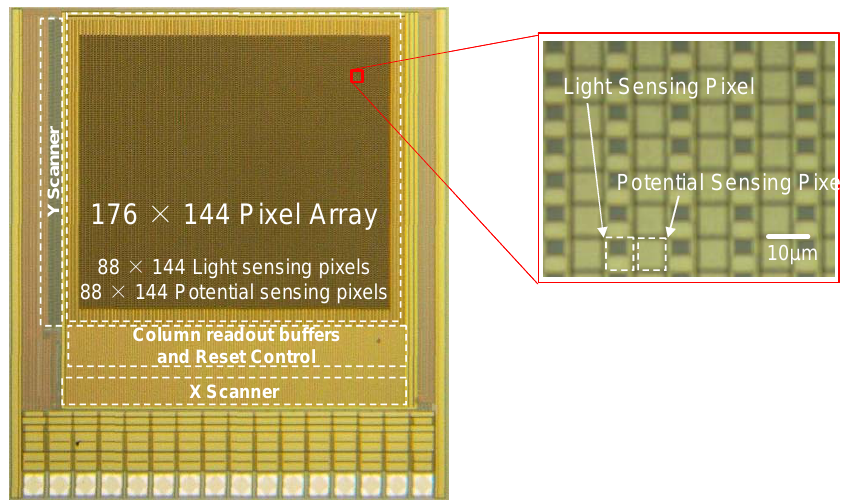
Figure 4. Layout of an optical + passive electric dual-image CMOS sensor (adapted from [1] © 2006 Elsevier Science).